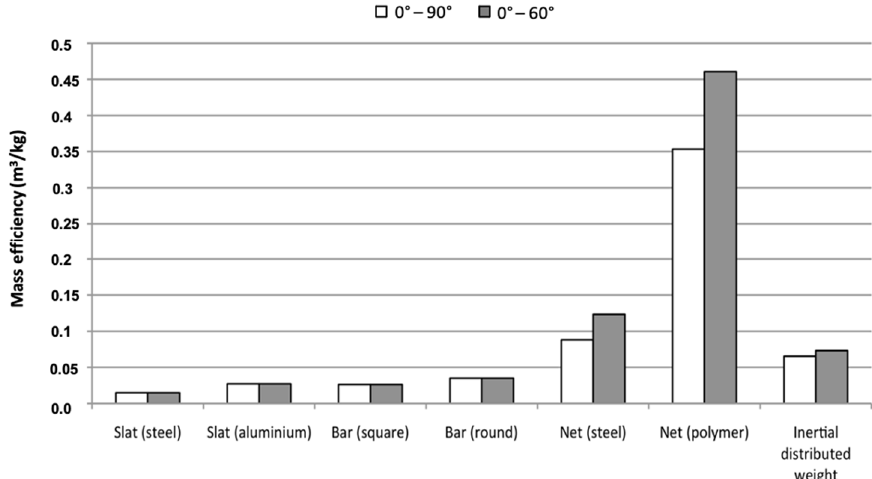
Figure 30. Mass efficiency of the different considered cage armour systems for a maximum vertical impact angle of 15° as a function of the considered horizontal impact angle range.